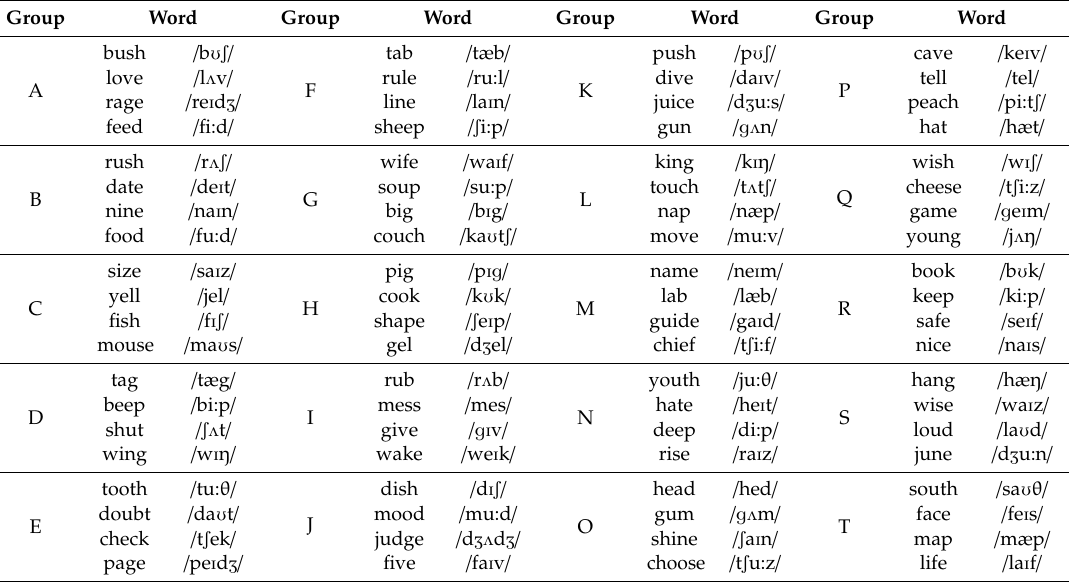
Table 1. The 80 CVC-words used in the English mosaic speech